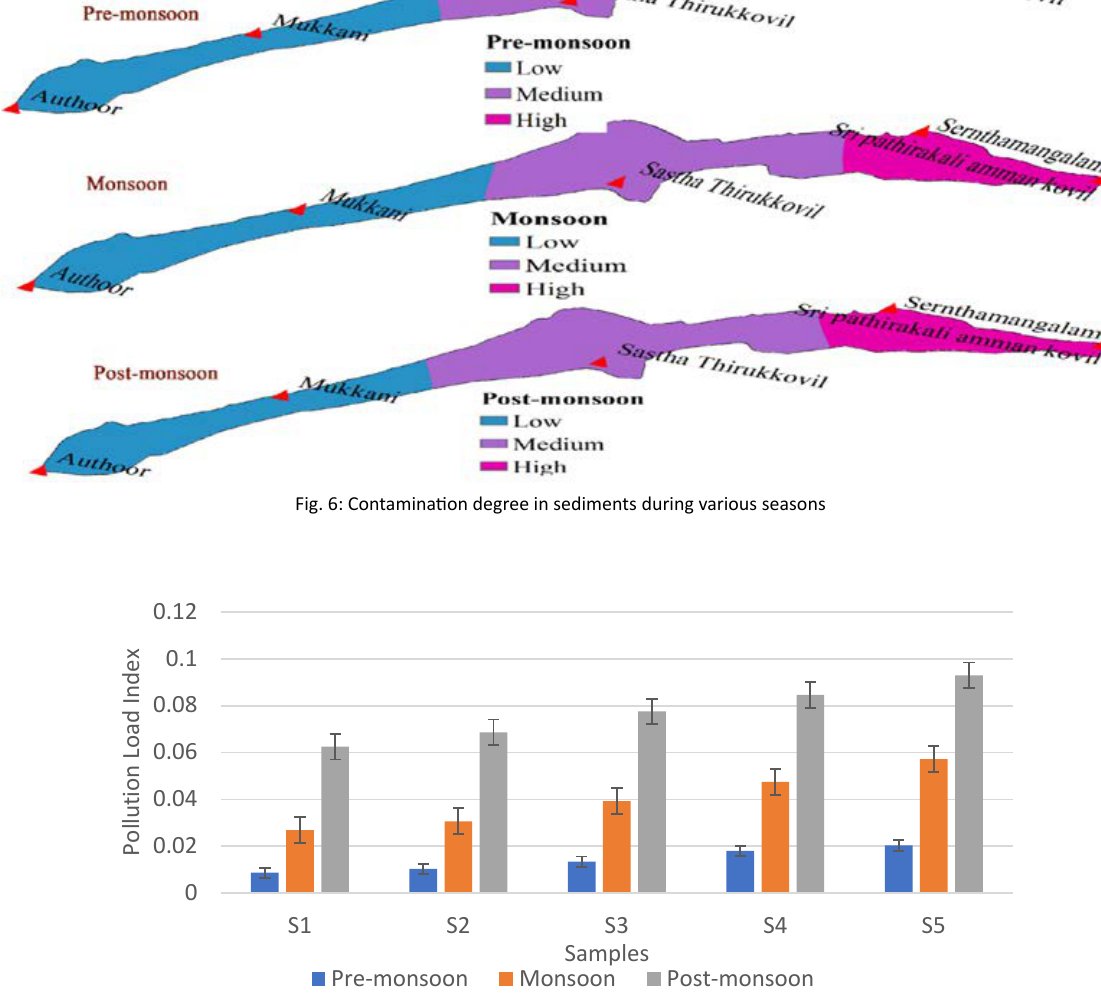
Fig. 7: Pollution load index in various seasons